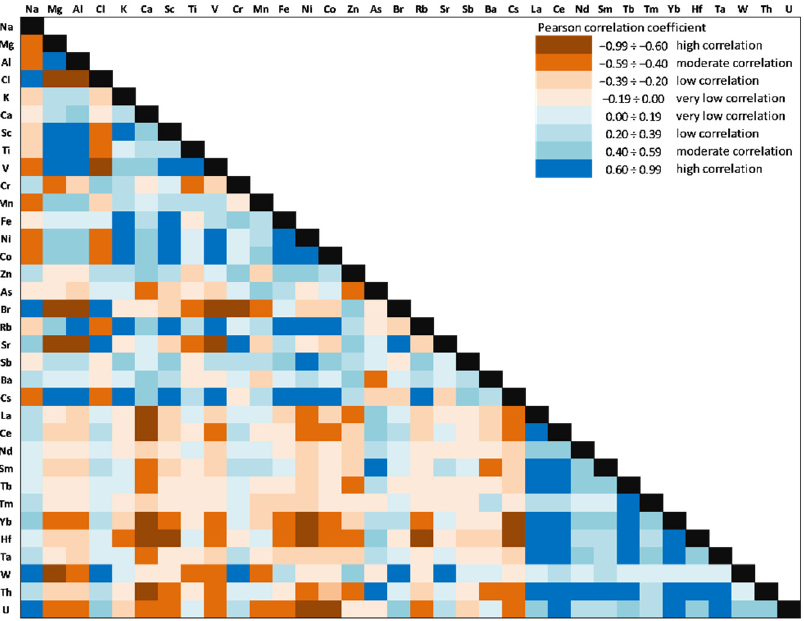
Figure 20. Pearson correlation map based on coefficient matrix for the relationship between the element concentrations in the Amara Lake sediment core. element concentrations in the Amara Lake sediment